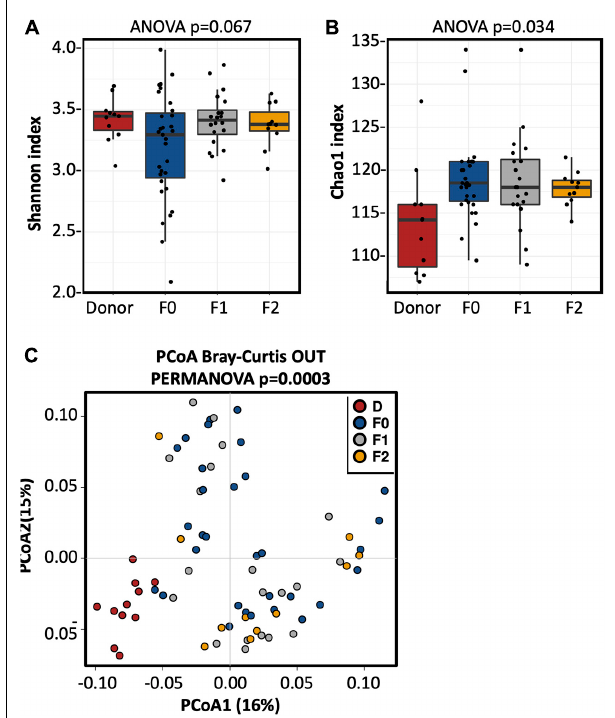
FIGURE 3 | The fecal microbiota alpha diversity increased in the UC patients after FMT. (A) Shannon index and (B) Chao1 index of the fecal microbiota in UC patients prior and after FMT treatments. ANOVA is performed to evaluate alpha diversity among the different groups. (C) PCoA analysis of the fecal microbiota in donor and UC patients prior and after FMT. Statistical significance of distances among the four groups was assessed using PERMANOVA. D, donor; F0, before FMT; F1, 2 ∼ 3 months after the first FMT, or before the second FMT; F2, 2 ∼ 3 months after the second